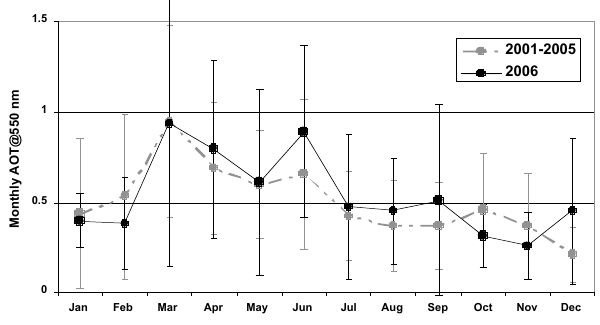
Fig. 25. Monthly mean aerosol optical thicknesses measured at Figure 25. Monthly mean aerosol optical thicknesses measured at 550 nm in Banizoumbou (Niger, 13.31°N/2.66°E; see its location on Fig.1) from 2000 to 2005 and in 2006 (The 550nm in Banizoumbou (Niger, 13.31 ◦ N/2.66 ◦ E; see its location monthly means are computed from daily averages available on the AERONET web site on Fig. 1) from 2000 to 2005 and in 2006 (the monthly means are http://aeronet.gsfc.nasa.gov/; for the 2006 data set the errors bars represent the monthly computed from daily averages available on the AERONET web site standard deviation; for the 2000-2005 average, the error bars represent the average monthly http://aeronet.gsfc.nasa.gov/; for the 2006 data set the errors bars standard deviation). represent the monthly standard deviation; for the 2000–2005 aver- age, the error bars represent the average monthly standard devia-